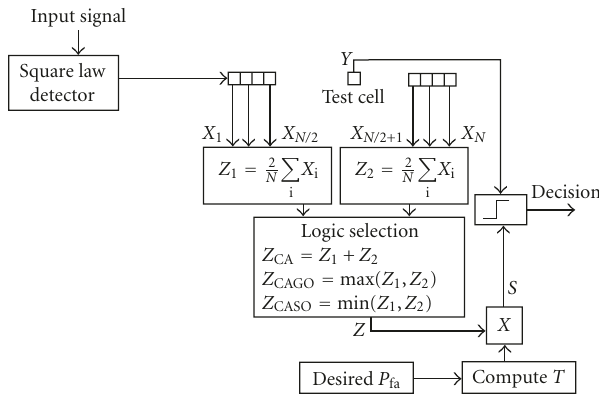
Figure 1: Block diagram of the CA, CAGO, and CASO-CFAR de- tector